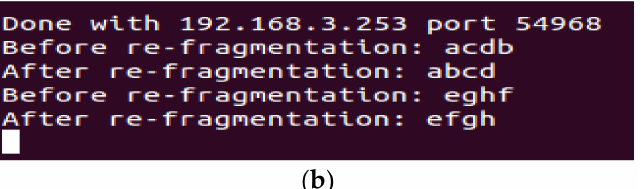
Figure 11. Re-fragmentation results between medical centers. ( a ) Sender. ( b ) Receiver.